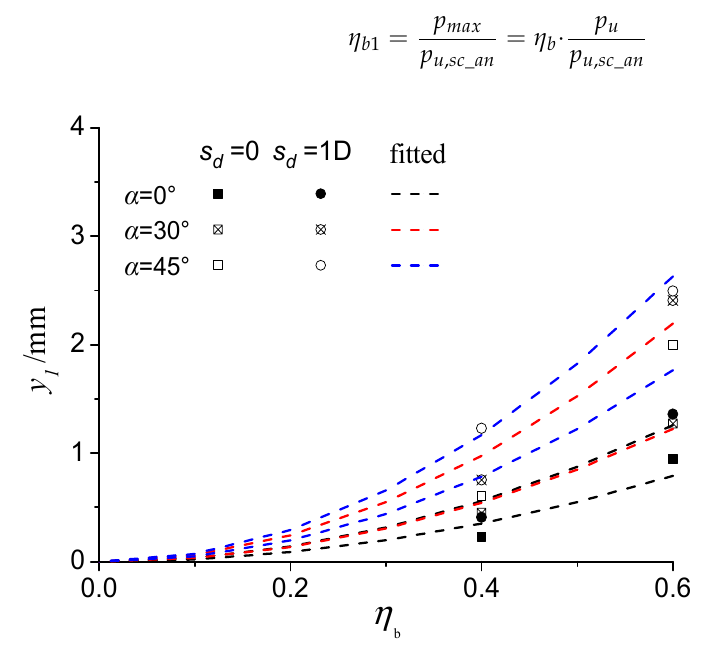
Figure 17. The value of y (cid:2869) to the cyclic amplitude η (cid:2912) .